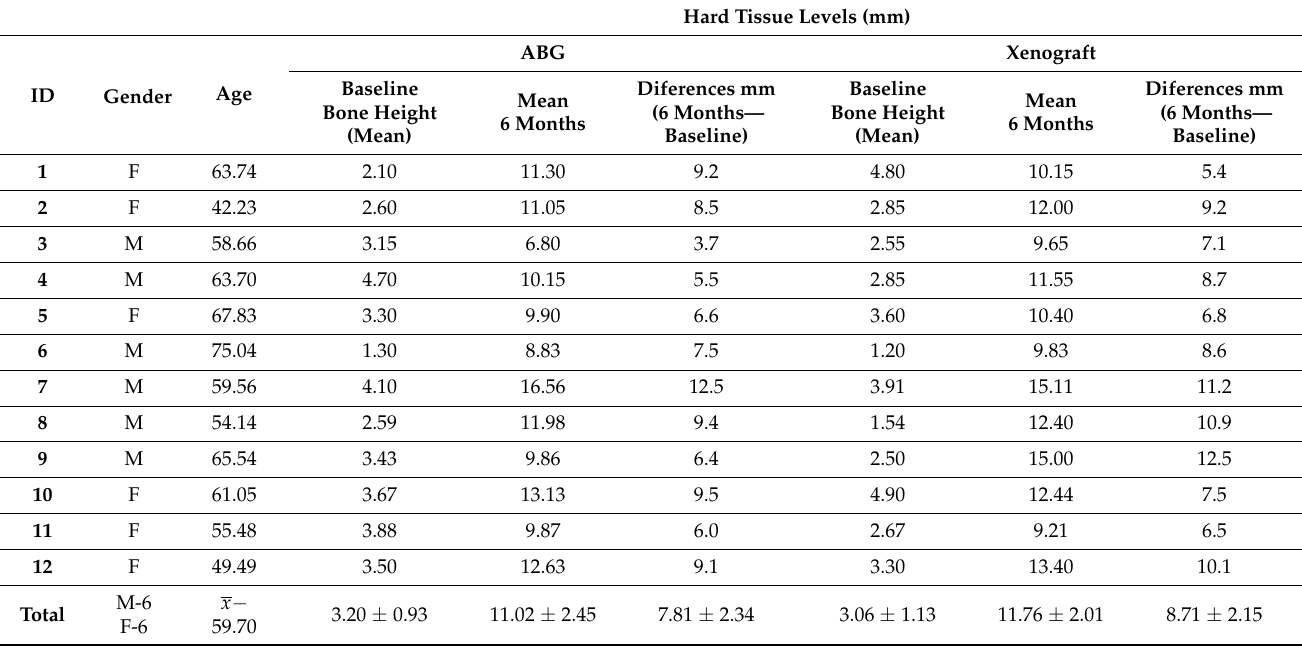
Table 1. Clinical observation and radiological